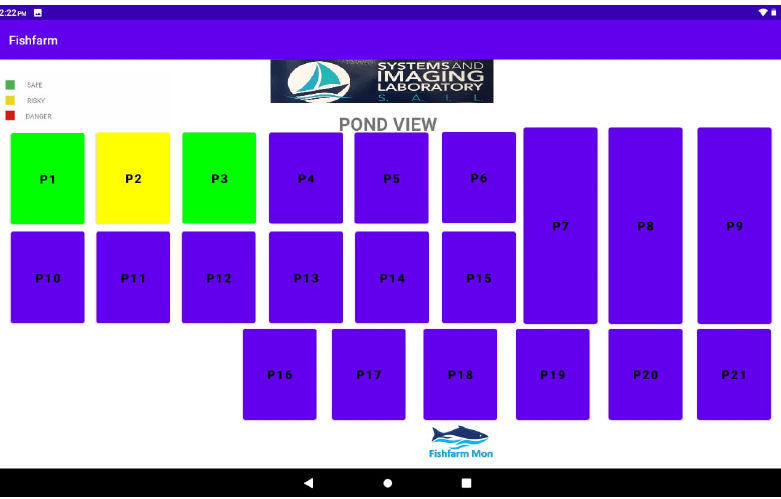
Figure 6. Android app displaying water quality readings sent by the